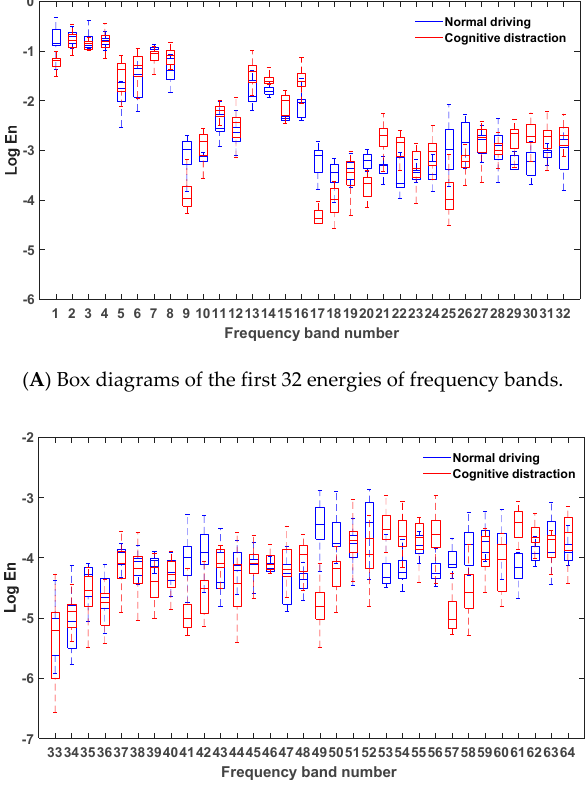
Figure 6. Box diagrams of the energies of frequency bands under di ff erent driving